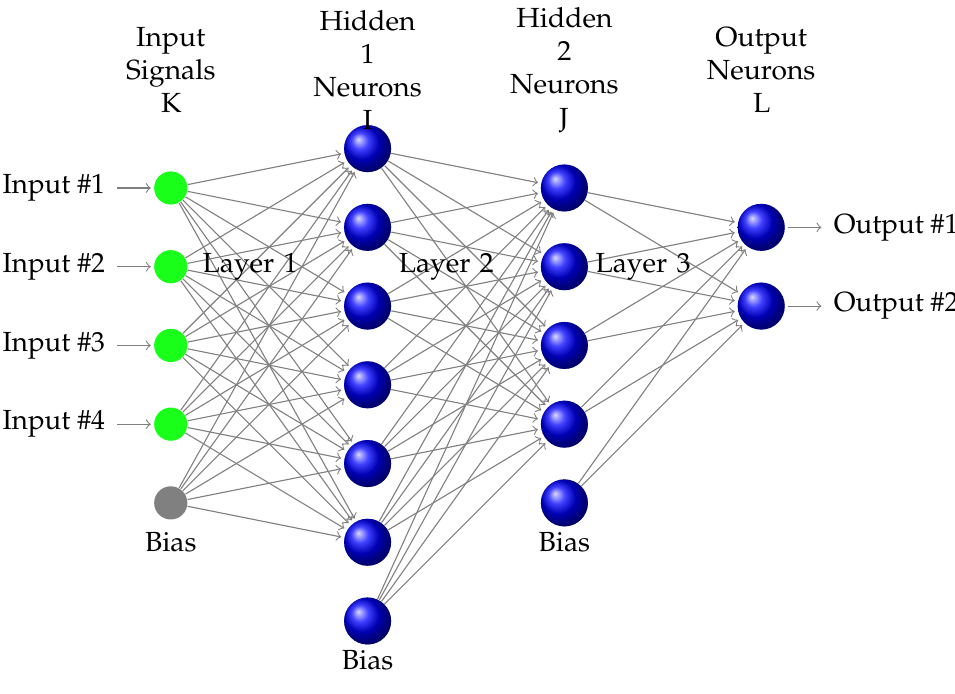
Figure 3. Multiplayer